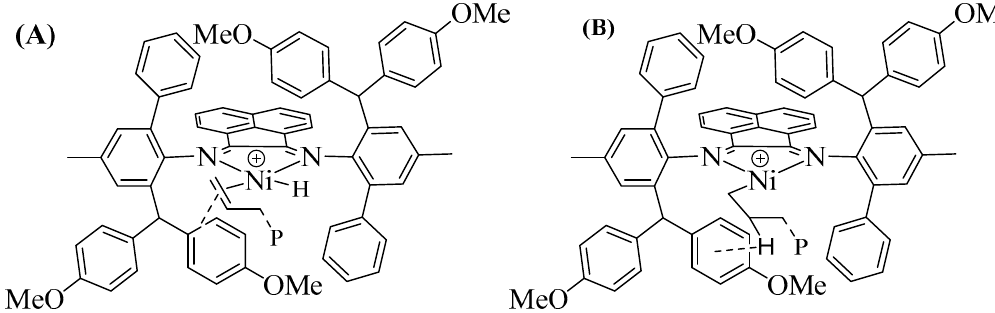
Figure 2. The comparison of polyethylene catalyzed by Ni1-3 within a certain temperature range (30–70 °C): ( a ) yield; ( b ) molecular weight; ( c ) branching density.